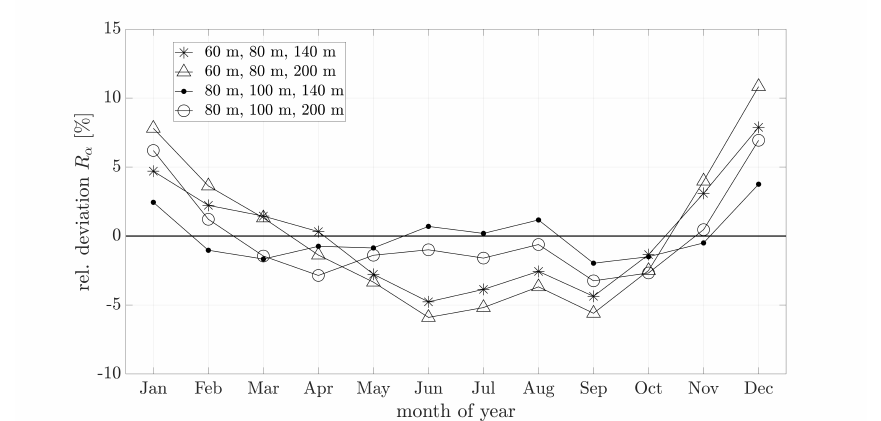
Figure 5. Relative deviation of monthly R α values from the yearly mean (based on monthly mean values of wind speed). Averaged over all sites and shown for different height